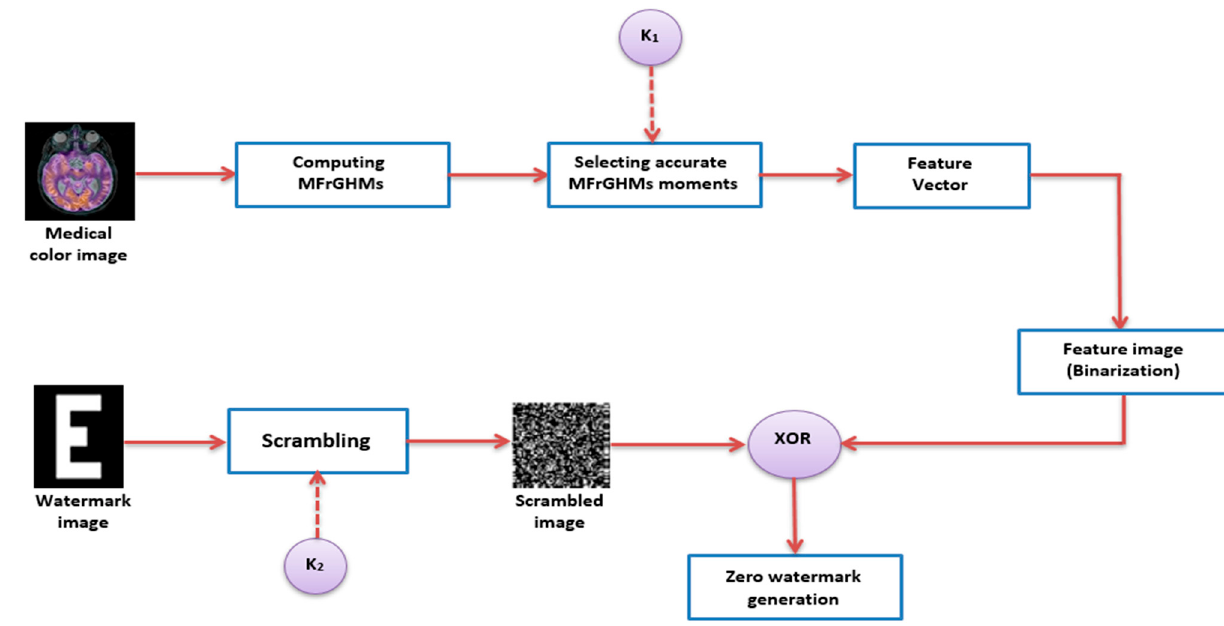
Figure 1. Generation of zero-watermark.